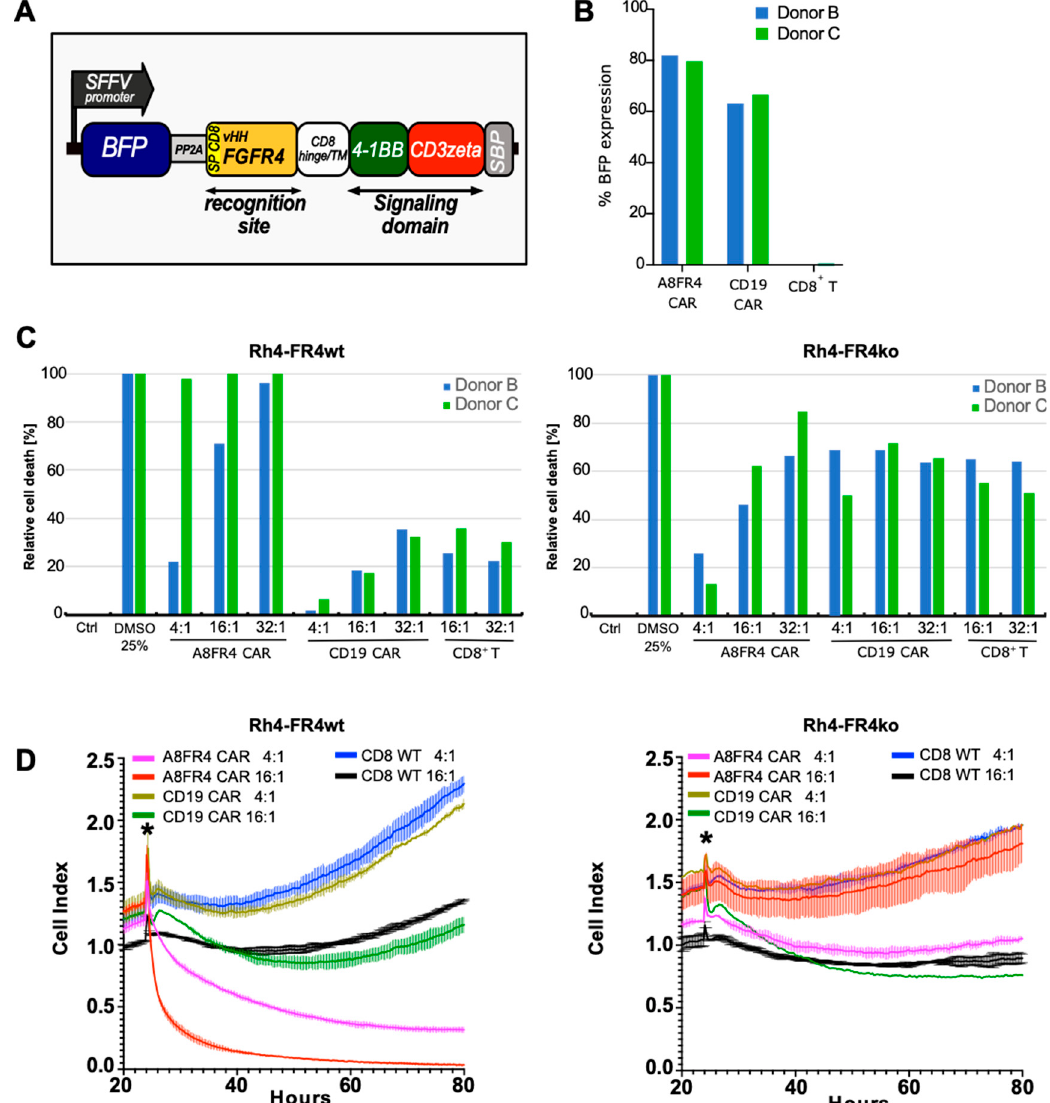
Figure 6. Cytotoxicity of FGFR4 chimeric antigen receptor (CAR) T cells towards Rhabdomyosarcoma (RMS) cells. ( A ) Schematic representation of the A8FR4 CAR construct. The CAR is composed of the sdAb A8 with CD8 α signal peptide sequence and C-terminal myc-tag followed by the hinge and transmembrane (TM) domains of CD8 α . Intracellular signaling domains are 4-1BB and CD3 ζ and are followed by a streptavidin binding peptide (SBP). ( B ) CD8 + T cell transduction efficiencies of donor B and C were determined by flow cytometry analysis of BFP signal. ( C ) Cytotoxicity was determined by luciferase activity of Rh4 cells co-cultured for 72 h with effector T cells of donors B and C. Relative cell death was highest for Rh4-FR4wt cells incubated with A8FR4 CAR T cells at the indicated effector:target (E:T) cell ratios in both donors. In Rh4-FR4ko cells, non-specific cell killing was observed for the co-cultivation of all CAR T cells and the non-transduced CD8+ T cells. ( D ) Real-time cell death analysis of Rh4 cells co-cultured with effector T cells from donor B using xCELLigence RTCA DP. A8FR4-CAR T cells showed higher killing activity at the indicated E:T cell ratios in Rh4-FR4wt compared to non-specific CD19 CAR T cells or non-transduced CD8 + T cells. In Rh4-FR4ko cells, no specific cytotoxicity was observed. Horizontal lines within the curves indicate the SD of the duplicate wells used during the assay. The asterisks indicate the time of addition of the effector T cells.